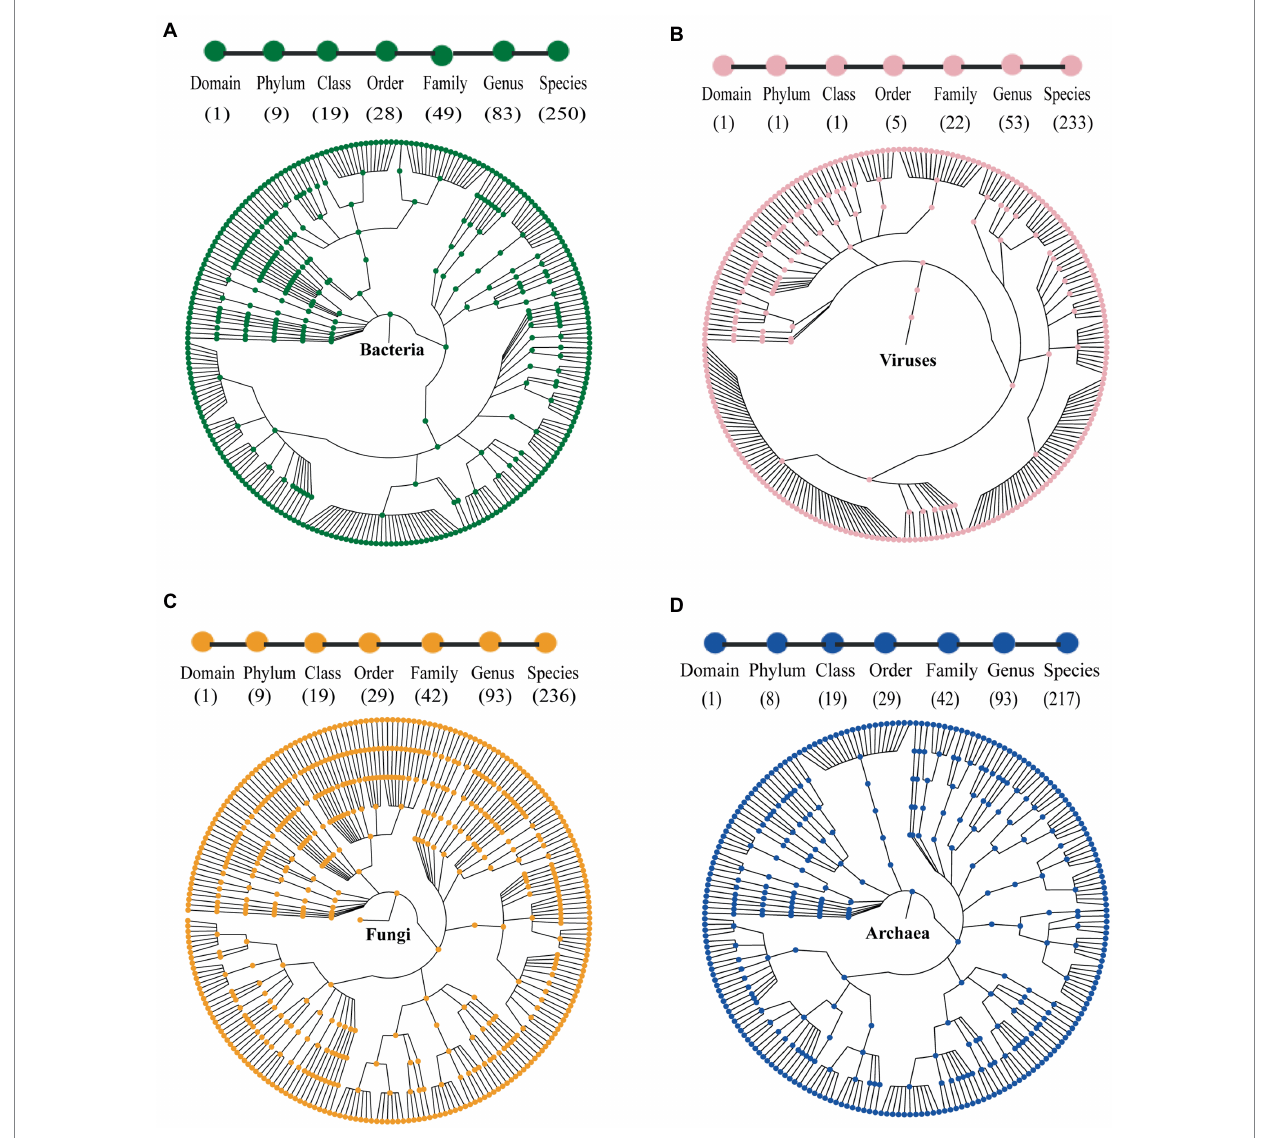
FIGURE 1 Taxonomic trees of (A) bacteria; (B) viruses; (C) fungi; and (D) archaea in the gut of marmots, predicted by MGS (metagenomics sequencing). From the inner to outer circles, the taxonomic levels range from kingdom to species. Numbers in parentheses indicate the total number of unique taxonomies detected at each